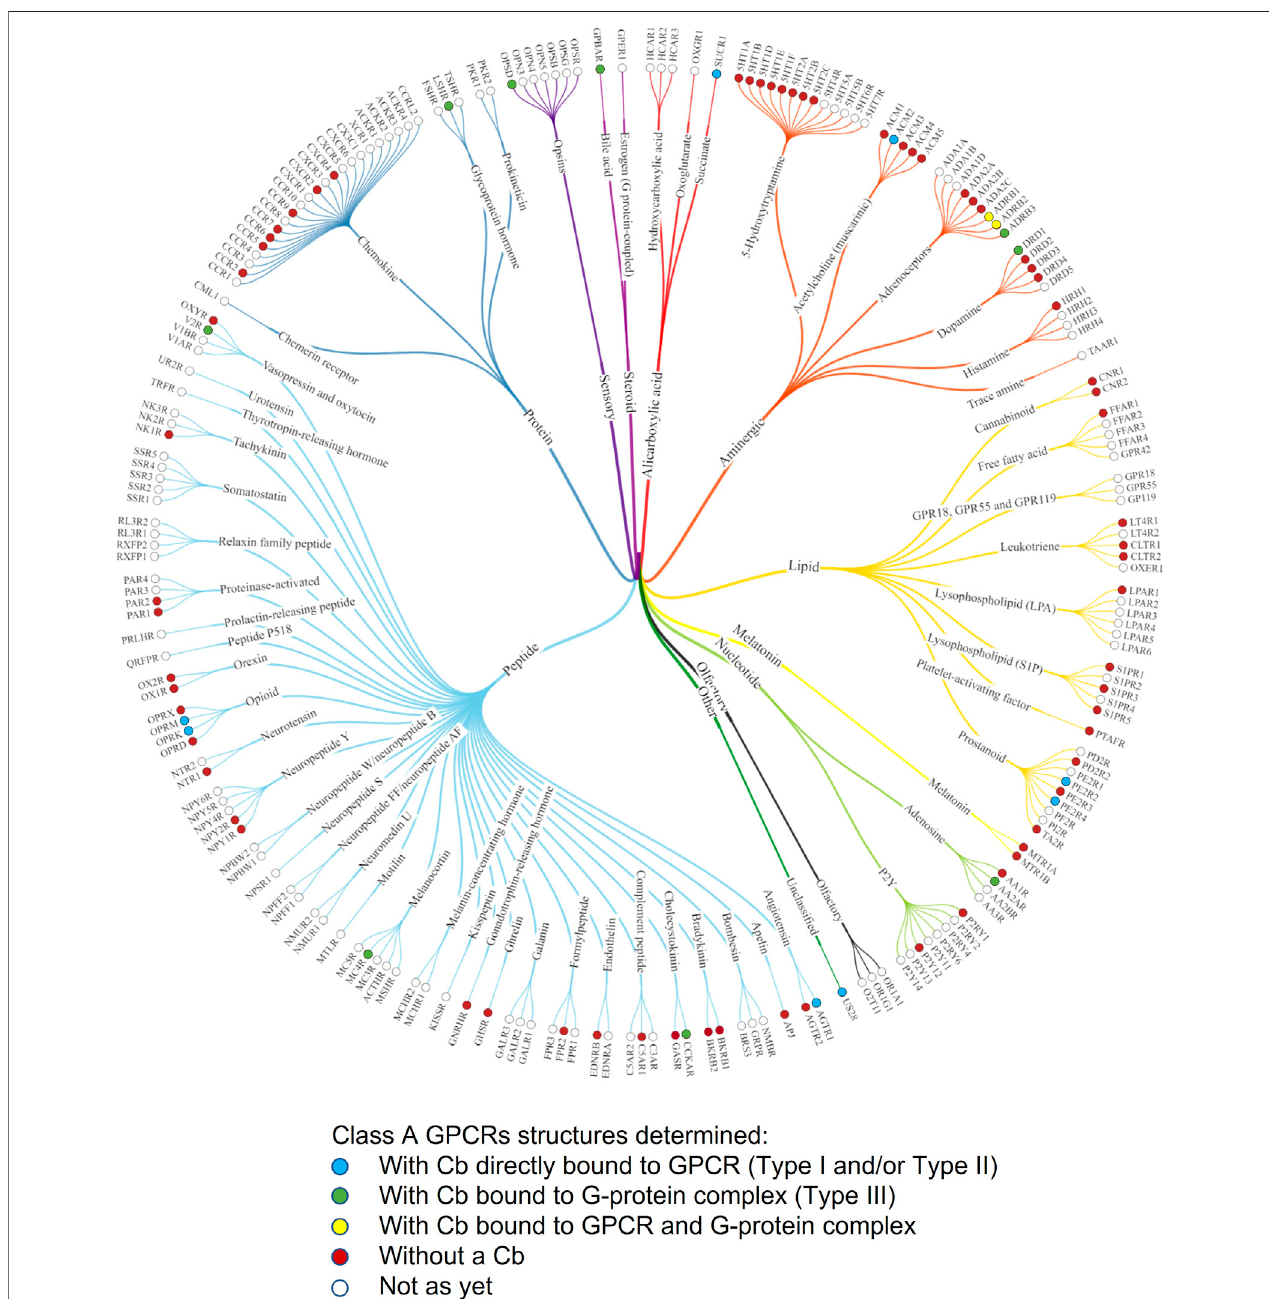
FIGURE 4 | Phylogenetic tree of Class A GPCRs indicating GPCR structures that have been solved with ConfoBodies. Receptors are referred to by their UniProt gene name. Figure adapted from the phylogenetic structural coverage plot for Class A GPCRs from GPCRdb, which excludes the orphan GPR52 receptor that was solved using a Type III Cb (Pándy-Szekeres et al., 2021). Structures captured up until